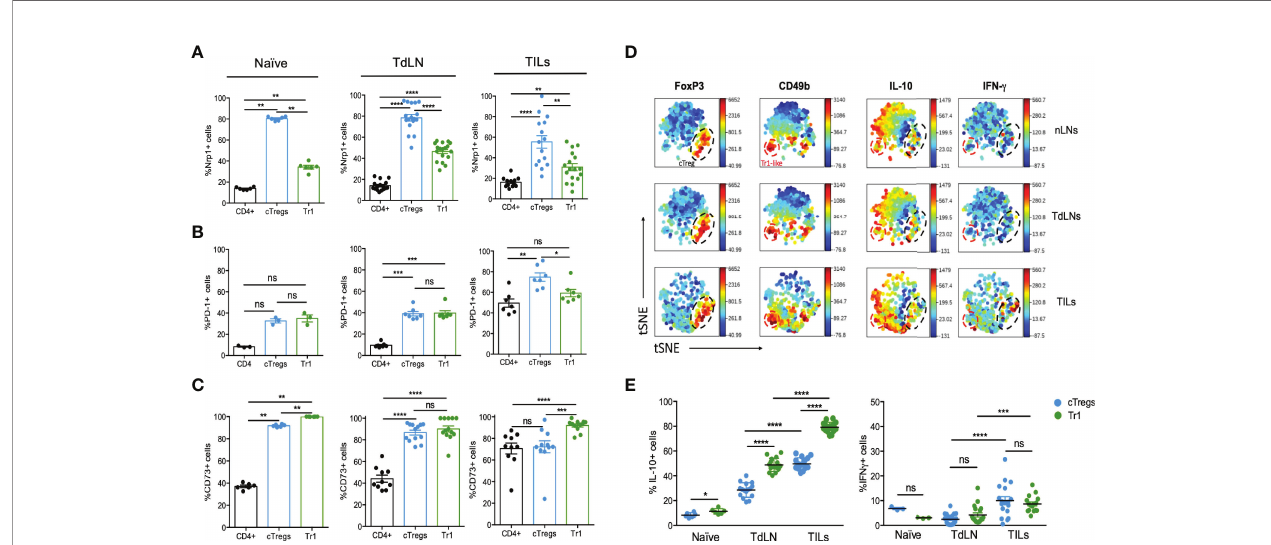
FIGURE 3 | Tr1 cells express Nrp-1, PD-1, and CD73. A total of 2 × 10 5 B16 cells were injected into the right fl ank of mice, and tumor growth was monitored and measured with caliper every other day. Between day 18 and 20 post-inoculation, mice were euthanized for cell phenotyping in naive inguinal lymph nodes (naive), tumor-draining lymph nodes (TdLNs), and tumor-in fi ltrating lymphocytes (TILs) using fl ow cytometry. The frequencies of CD4+ T cells, cTreg, and Tr1 cells expressing Nrp-1 (A) , PD-1 (B) , and CD73 (C) were evaluated as shown in the indicated graphs. Data from two independent experiments are shown as the mean ± SEM. n = 3 – 6 mice per experiment. * p < 0.05; ** p< 0.01; *** p < 0.001; ns, not signi fi cant according to one-way ANOVA (multiple comparison). (D, E) . Inguinal (naive) and tumor-draining lymph nodes (TdLNs), in addition to tumor-in fi ltrating lymphocytes (TILs), were processed for the analysis of CD4, Foxp3 GFP , CD49b, IL- 10, and IFN- g expression by fl ow cytometry. (D) Representative viSNE map of concatenated fi les of all samples and concatenated individual populations. Frequencies of cTreg and Tr1 cells producing IL-10 ( E , left) or IFN- g ( E , right) in the indicated cells/organs, obtained by intracellular staining. Data from three independent experiments are shown as the mean ± SEM. n = 4 – 5 mice per experiment. * p < 0.05; ** p< 0.01; **** p < 0.0001; ns, not signi fi cant according to one- way ANOVA (multiple